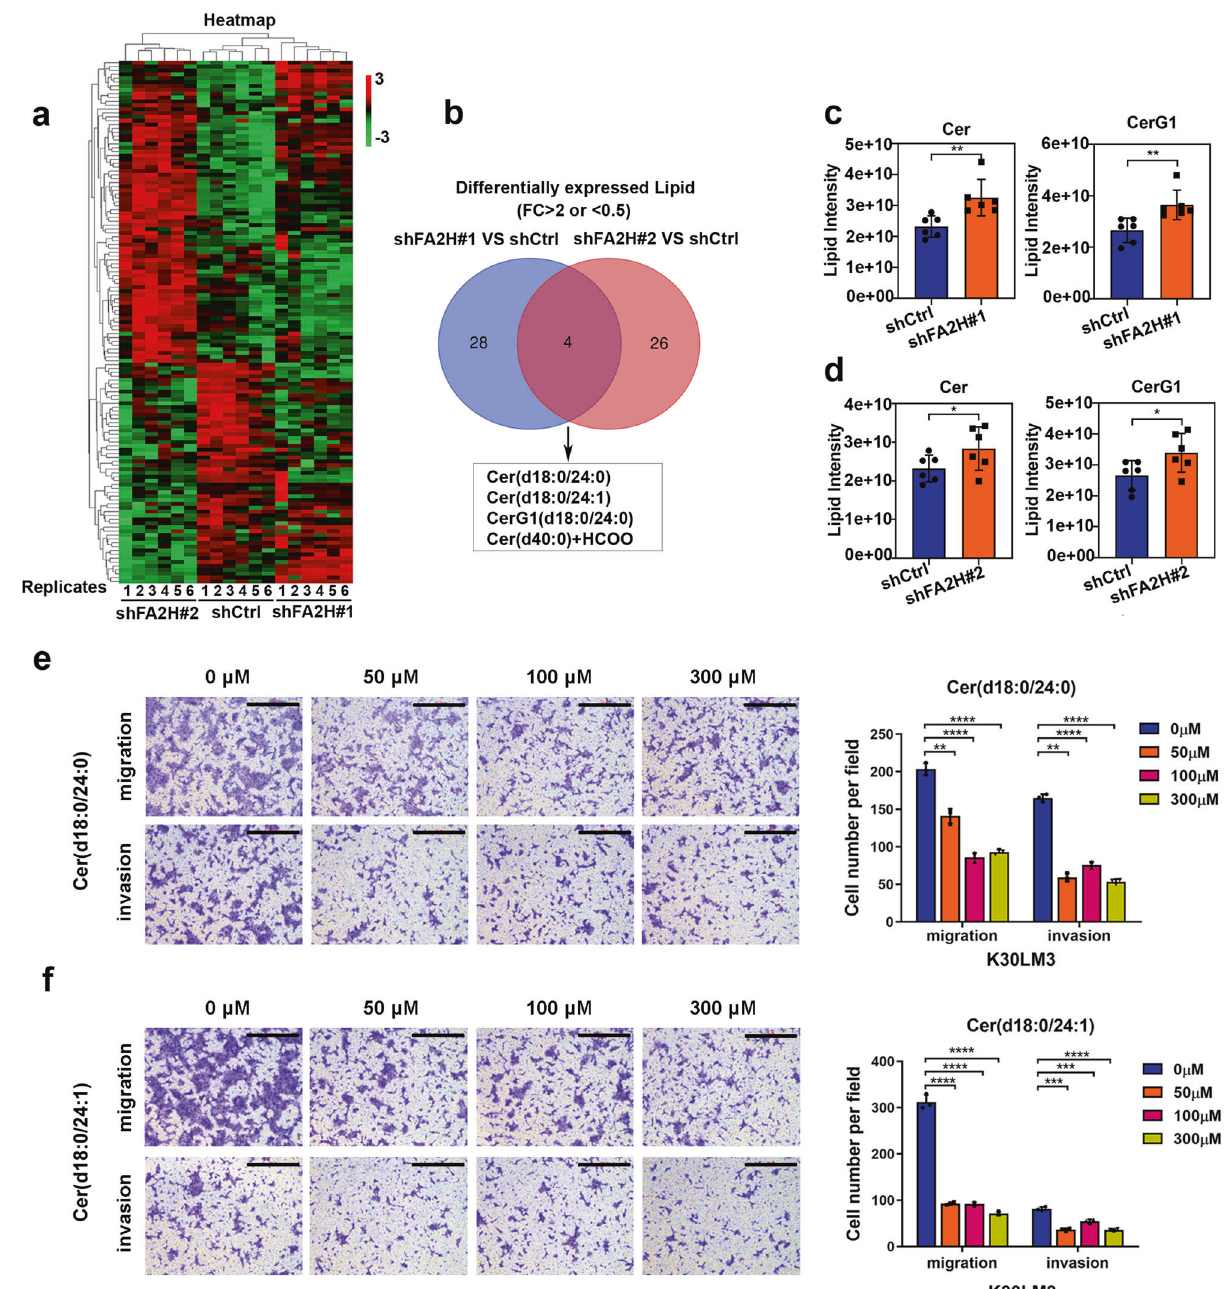
Fig. 3 FA2H inhibits metastasis in LM cells by rewiring ceramide metabolism. a A heatmap showing the differential lipid species identi fi ed from lipidomics analysis in K30LM3 cells expressing two independent shRNA targeting FA2H , or a control hairpin (shCtrl). b Venn diagrams showing differential lipids identi fi ed in FA2H -depleted and control K30LM3 cells. c , d Two lipid species identi fi ed from K30LM3 expressing two independent shRNA targeting FA2H . e Transwell assay was performed to evaluate the effect of Cer (d18:0/24:0) on migration and invasion ability of K30LM3 cells. Scale bar, 500 µm. f Transwell assay was performed to evaluate the effect of Cer (d18:0/24:1) on migration and invasion ability of K30LM3 cells. Scale bar, 500 µm. Error bars denote mean ± SD. ** P < 0.01, *** P < 0.001, **** P <